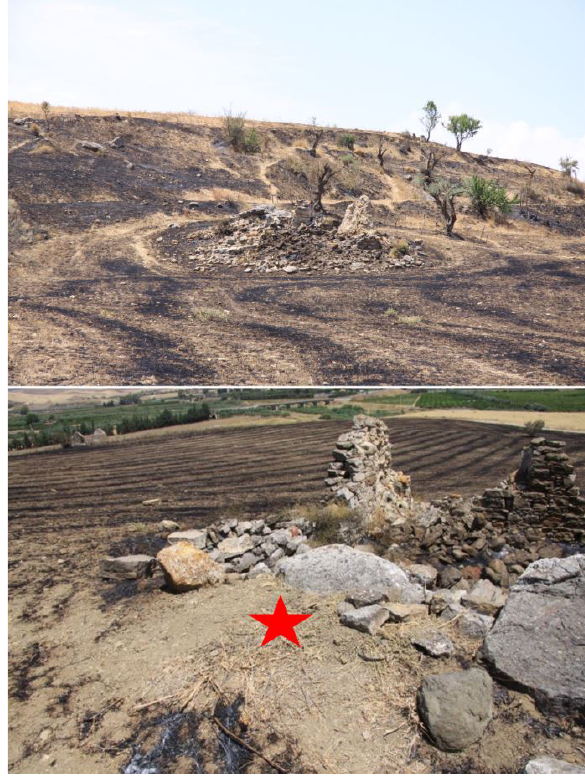
Figure 12. Pictures showing the rests of a fire near the location of a seismic station. Red star marks the station position. The fire covered a big area all around the station but no damage to the instruments has